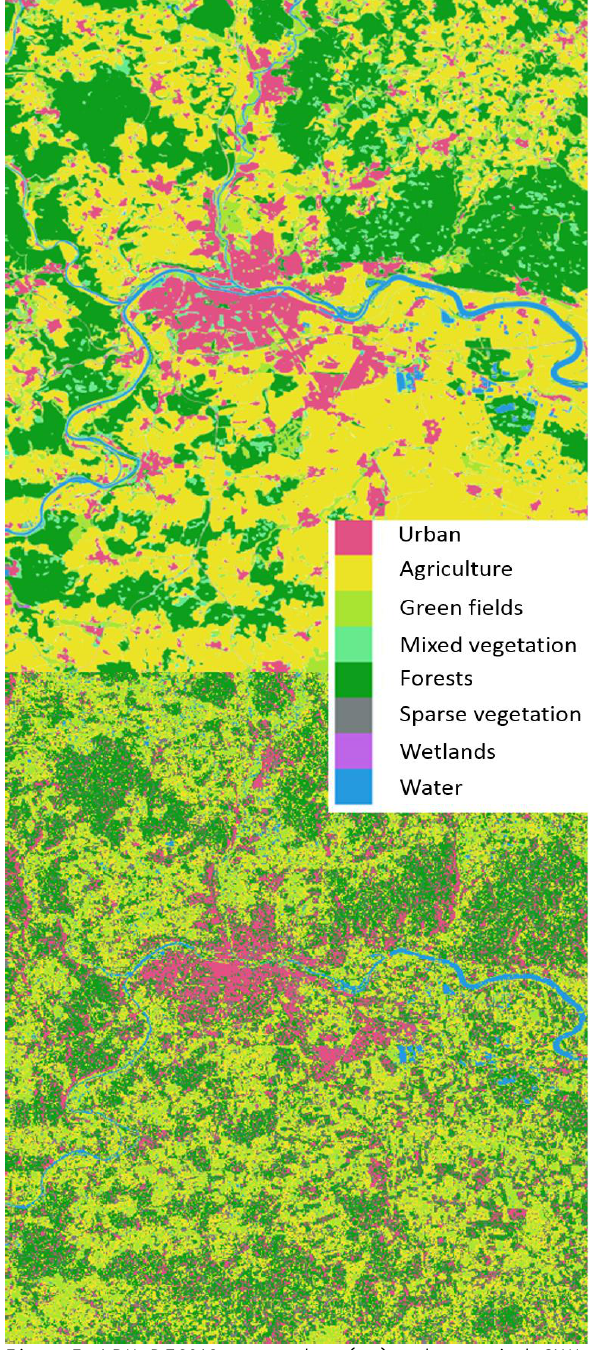
Figure 7. LBM-DE2012 source data (top) and supervised SVM classification results from the VH-VV composite of the SAR image from 20 Jul. 2015 (bottom) colour coded as eight